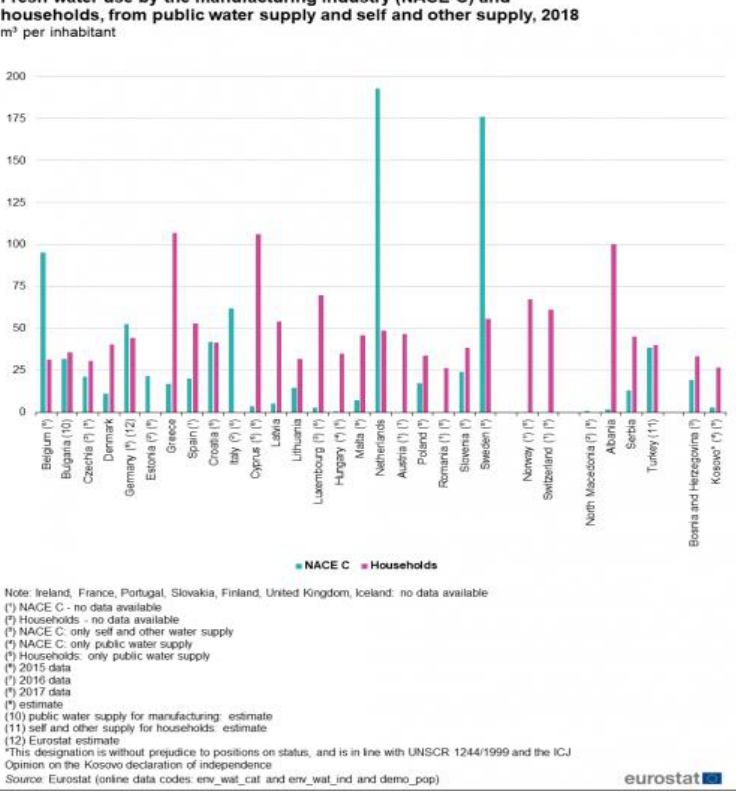
Figure A3. Drinking water consumption in the EU in 2018, m 3 per inhabitant. Source: Water statistics—Statistics Explained (europa.eu) (accessed on 20 May 2021).